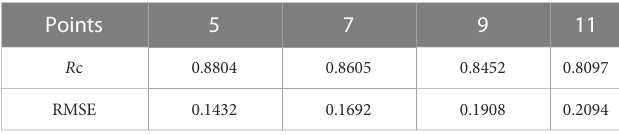
TABLE 1 Preprocessing results with different window